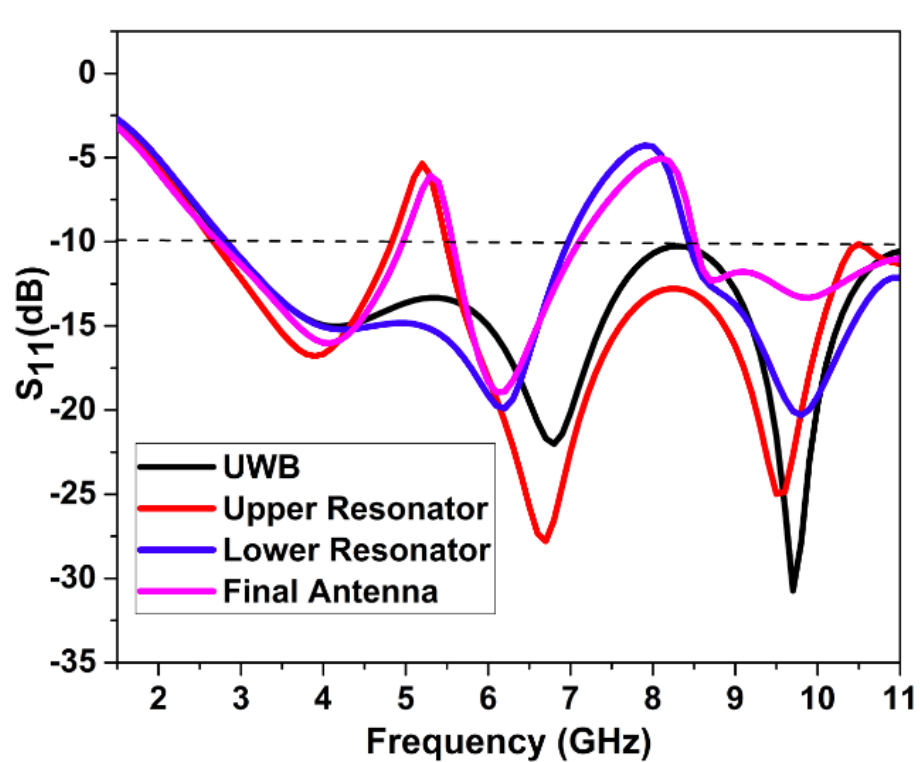
Figure 6. S11 characteristics of progression stage of UWB notch antenna.